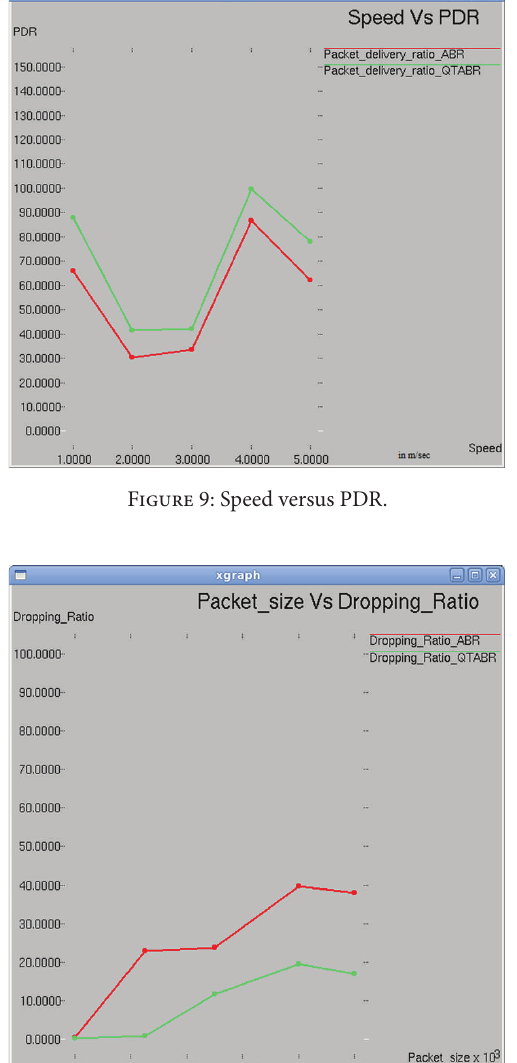
Figure 10: Packet size versus packet dropping ratio.